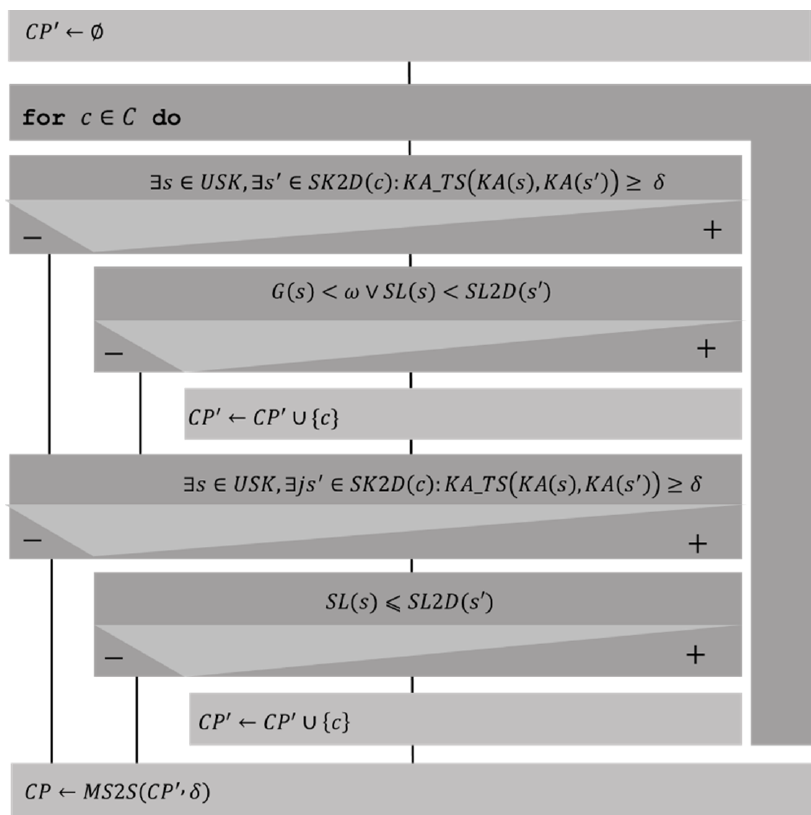
Figure 6. Initial course prediction algorithm.